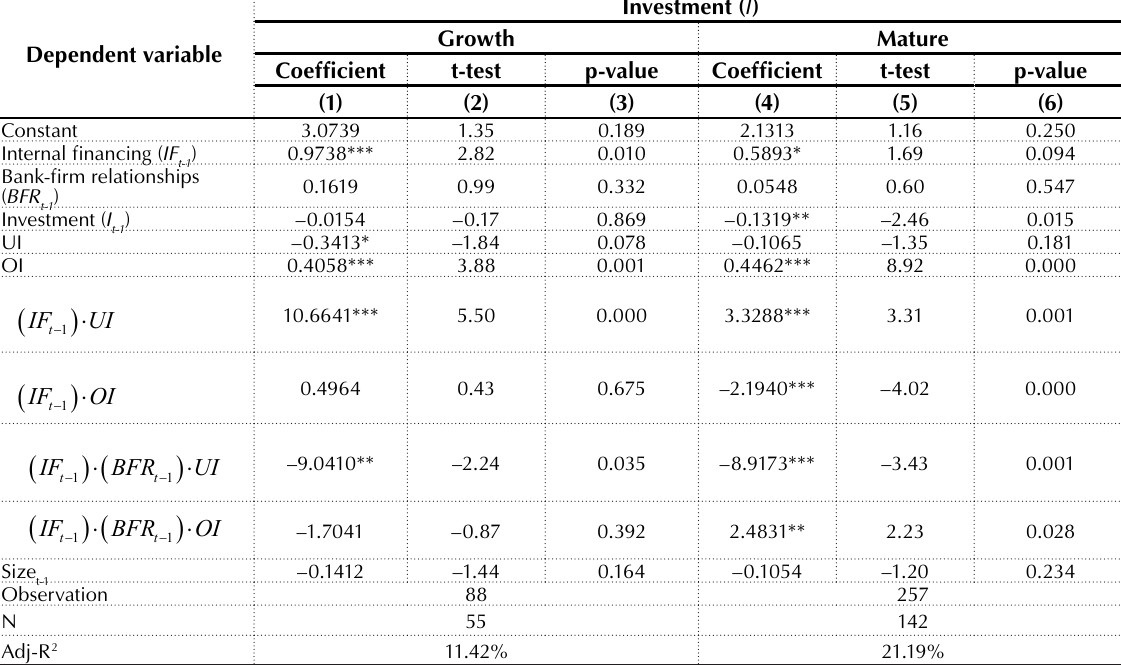
Table 4. The role of bank-firm relationships in overcoming underinvestment and overinvestment Dependent